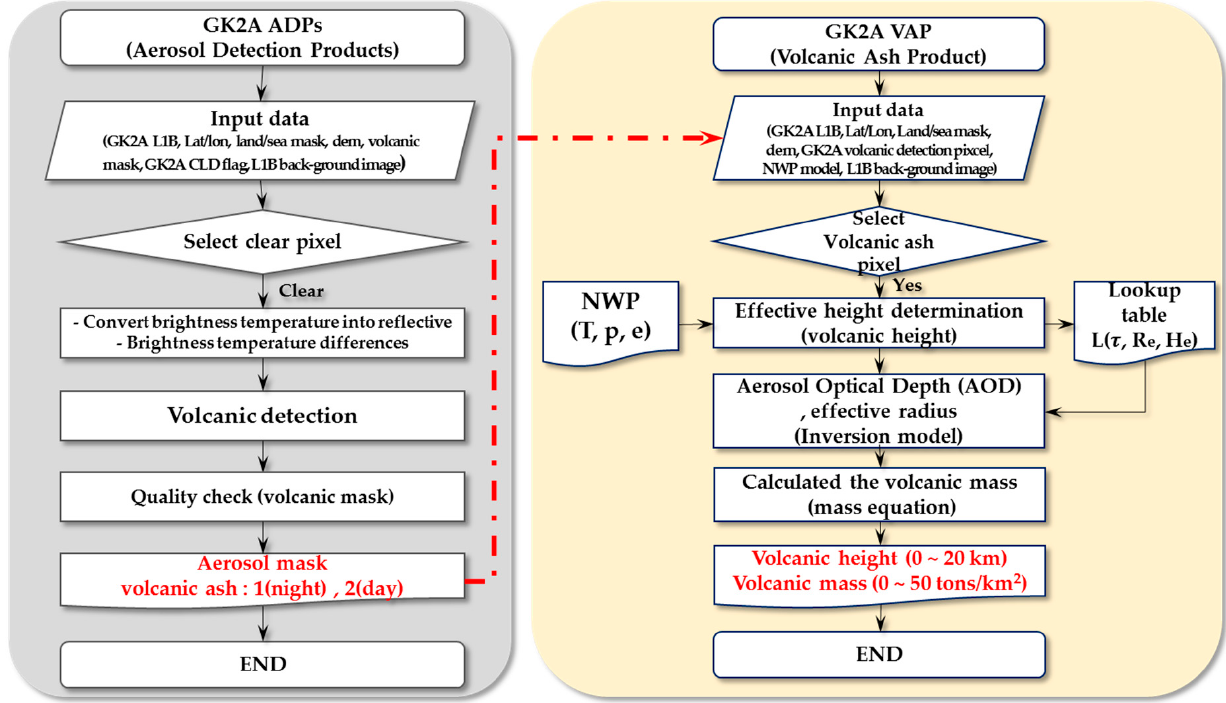
Figure 1. Flowchart of the volcanic ash product algorithm used by GK-2A/AMI. Aerosol Optical Depth Lookup